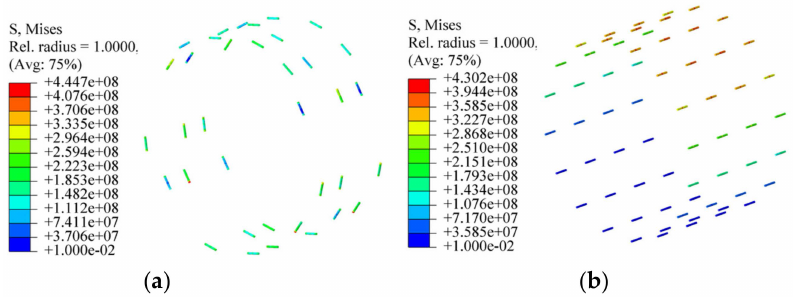
Figure 13. Stress of joint bolts subjected to reverse fault displacement. ( a ) Stress of circumferential bolts and ( b ) stress of circumferential bolts. Some like +4.447e+08 means 4.447 × 10 8 .